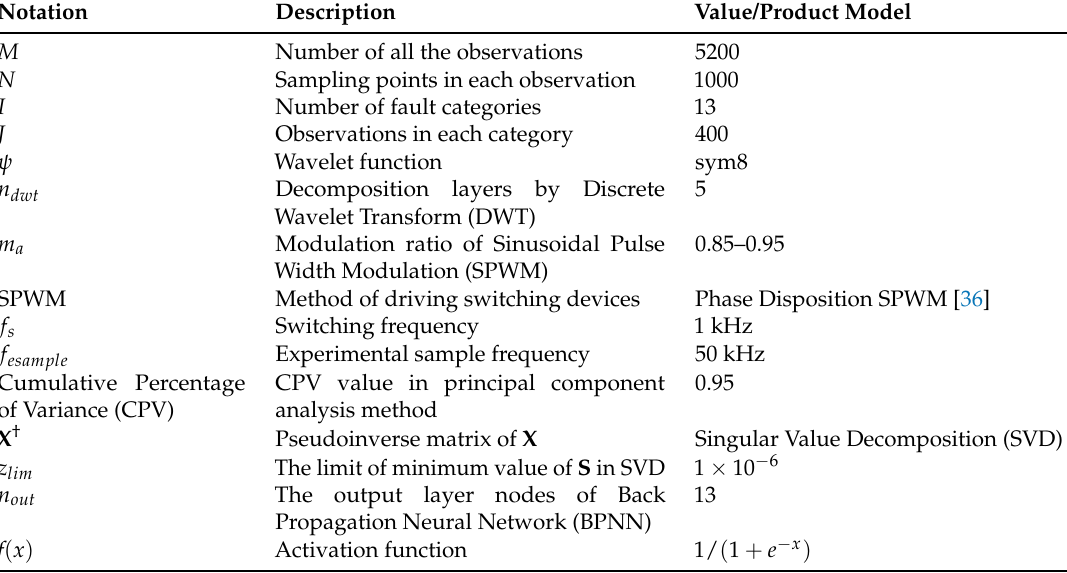
Table 3. Main parameters of the fault diagnosis strategy.